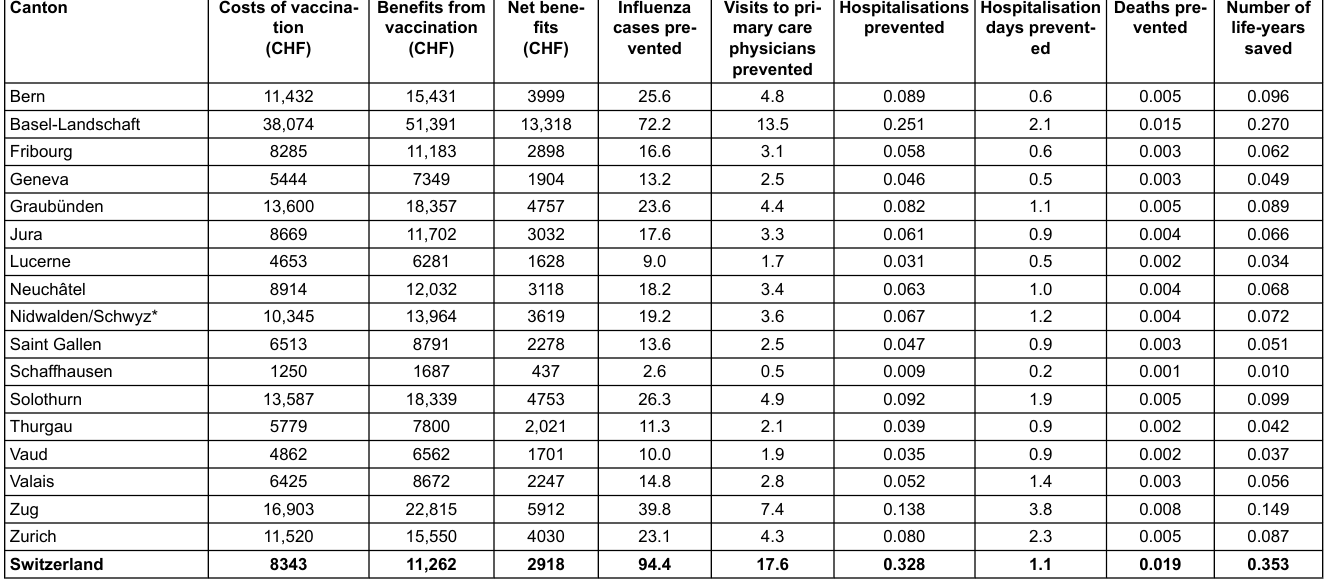
Table 6: Costs and benefits of influenza vaccination for healthy 19- to 65-year-olds in the pharmacies of the individual cantons per 100,000 population in the 2017/18 influenza season. The denominator corresponds to healthy 19- to 65-year-olds on 31 December 2017. Canton Costs of vaccina-